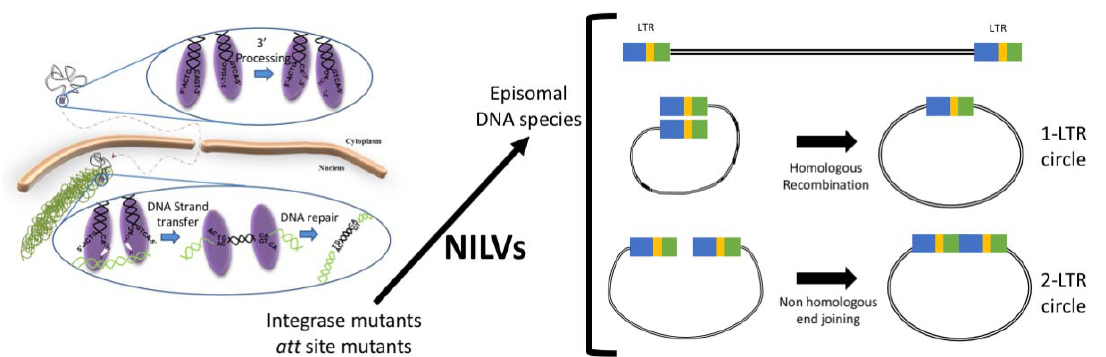
Figure 1. Schematic diagram of integration process, with 3 ′ processing depicted where the viral enzyme integrase removed a dinucleotide from the ends of the viral DNAs, while binding to the attachment (att) sites and the nucleophilic attack of the recessive ends to the target genome in a catalytic process called DNA strand transfer. Integrase and/or att mutations render these vectors non ‐ integrative, giving origin to episomal vector DNA species that can either be linear or circular, with the latter being the origin of homologous recombination (originating one ‐ LTR (long terminal repeat) circles) or products of non ‐ homologous end ‐ joining (circles with two LTRs).